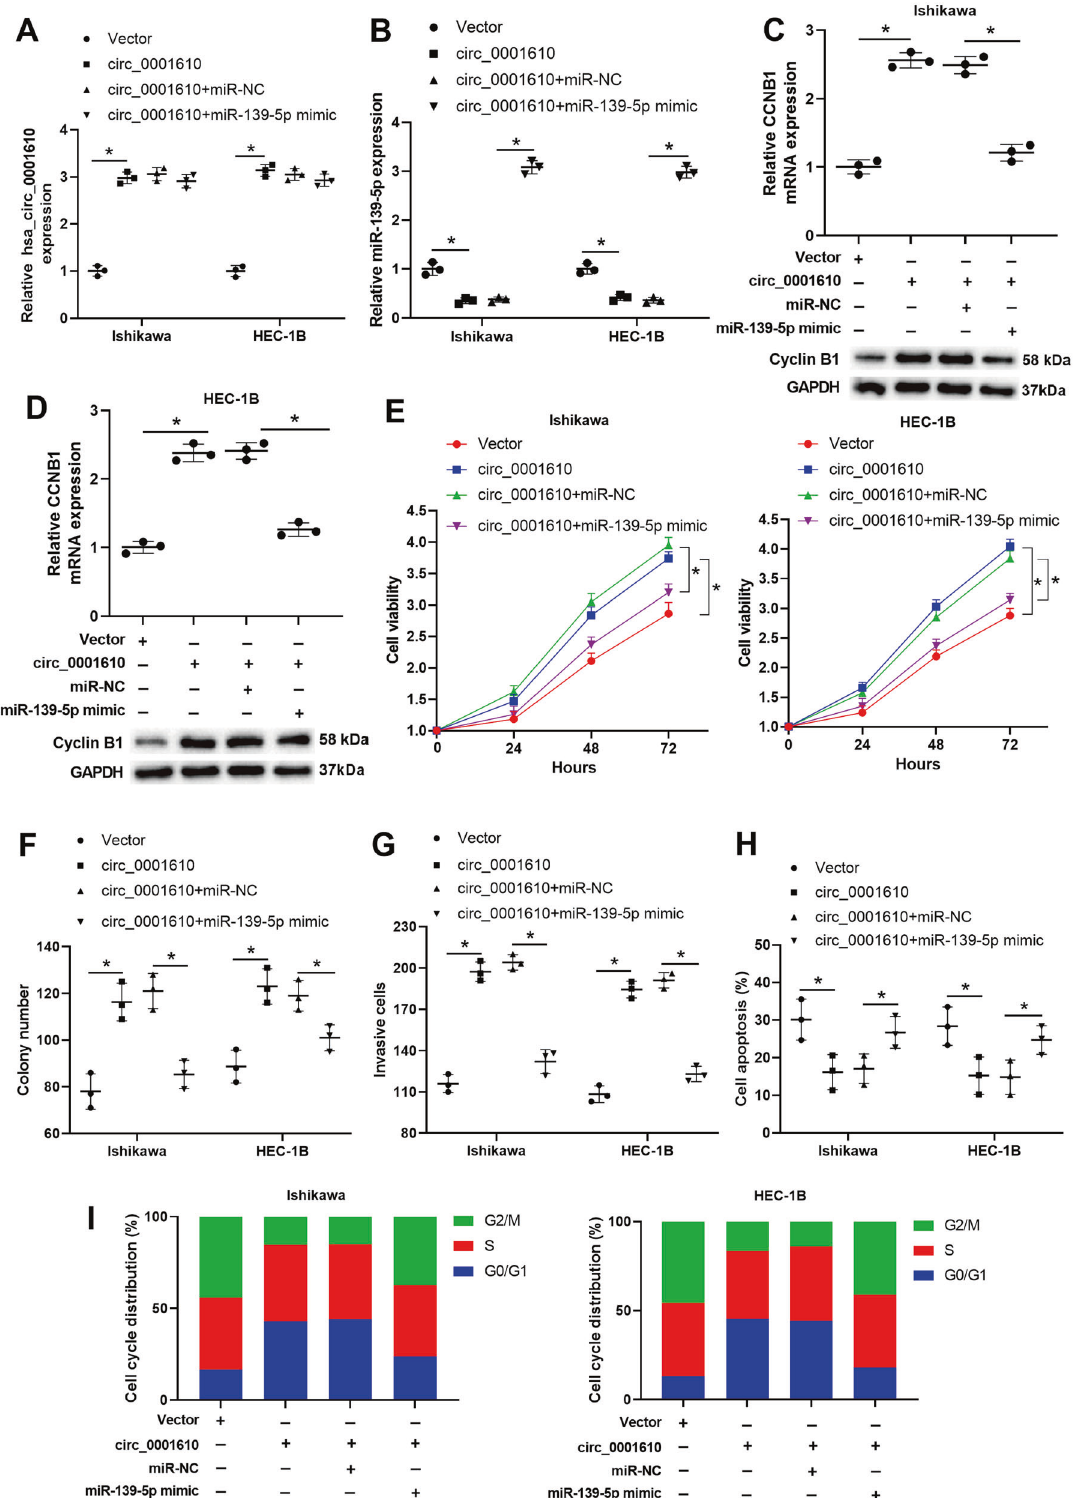
Fig. 5 Hsa_circ_0001610 weakened the radiosensitivity of EC cells by suppressing the miR-139-5p expression. Ishikawa and HEC-1B cells were transfected with vector, hsa_circ_0001610, hsa_circ_0001610 + miR-NC, or hsa_circ_0001610 + miR-139-5p mimic, followed by exposure to 4 Gy irradiation. The expression levels of A hsa_circ_0001610 and B miR-139-5p was measured by qRT-PCR. The mRNA and protein levels of cyclin B1 in C Ishikawa and D HEC-1B cells were measured by qRT-PCR and Western blot, respectively. E Cell viability was measured by MTT assay. F Cell proliferation was measured by colony formation assay. G Cell invasion was measured by Transwell assay. H Cell apoptosis was measured by fl ow cytometry. I Cell cycle distribution was determined by PI staining. * p < 0.05.